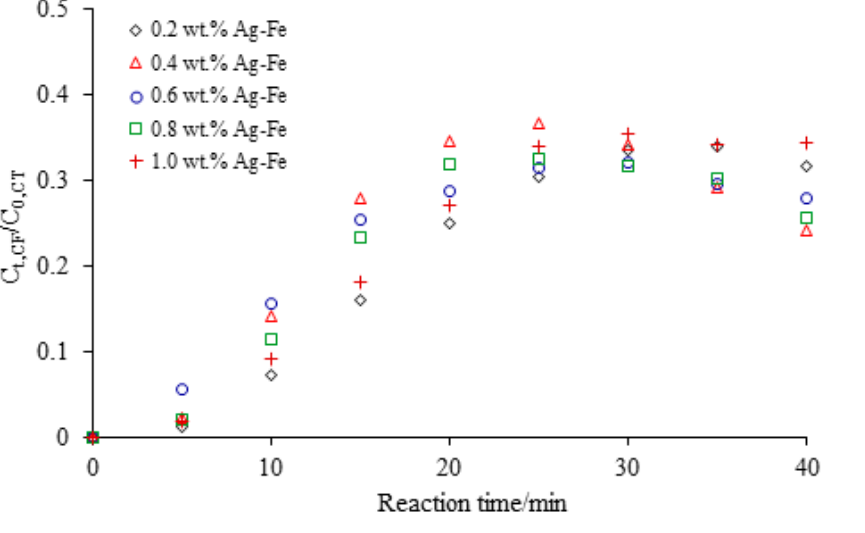
Figure 5. Changes in chloroform concentration at 20 g/L Ag/Fe particles with different Ag loading. C 0,CT is the initial CCl 4 molar concentration, and C t,CF is the CHCl 3 molar concentration at time